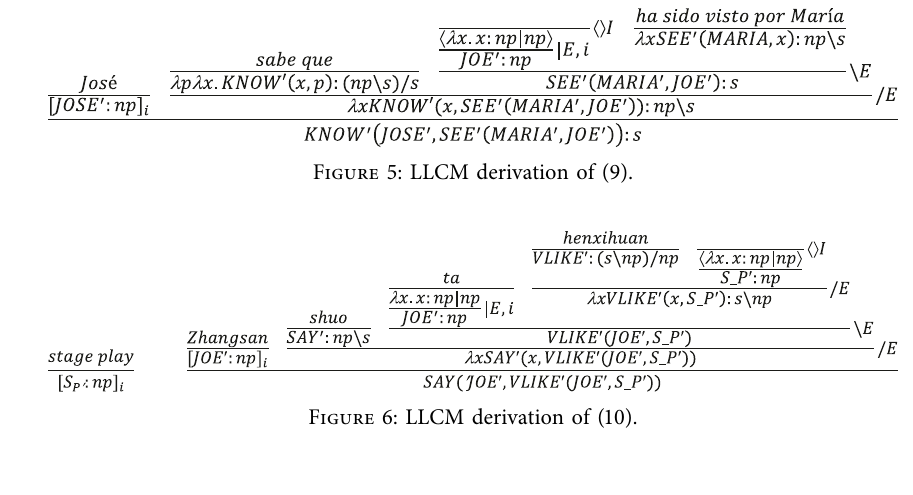
Figure 6: LLCM derivation of